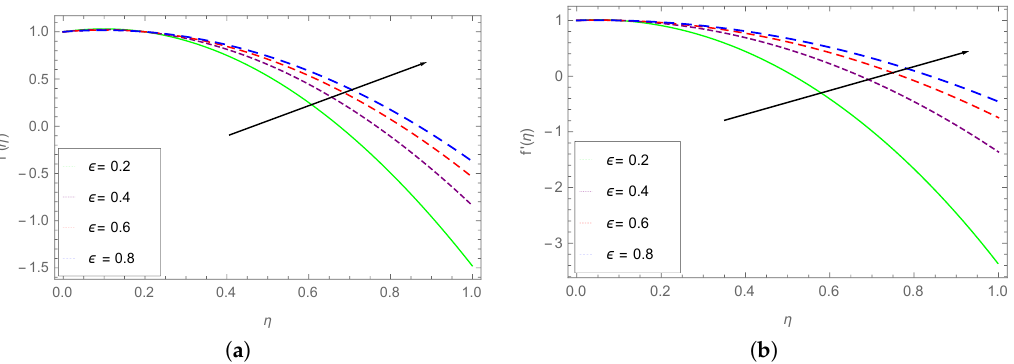
Figure 3. ( a ) Impact of (cid:101) on f (cid:48) ( η ) , when β = 0.1, S = 0.2 and ( b ) Impact of β on f (cid:48) ( η ) , when β = 0.05, S =